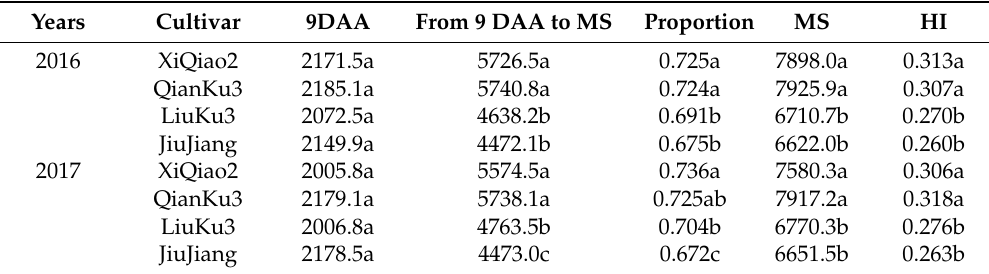
Figure 6. Trend of transpiration rates (T r ) in the leaves of four Tartary buckwheat cultivars at different flowering nodes. Panels ( A – D ) represent the leaves of 6th, 7th, 8th, and 9th flowering nodes, respectively. Data are the means ± SD in two years (2016 and 2017). a and b indicate significant difference (at p < 0.05) in T r at the same day after anthesis among four cultivars. NS represent no significant difference in T r at the same day after anthesis among four cultivars. Table 2. Total plant dry matter (kg ha –1 ) at 9 d after anthesis (9 DAA) and maturity stage (MS), biomass accumulation from 9 DAA to MS, proportion of total dry matter accumulated from 9 DAA to MS, and HI in four Tartary buckwheat cultivars in 2016 and 2017.